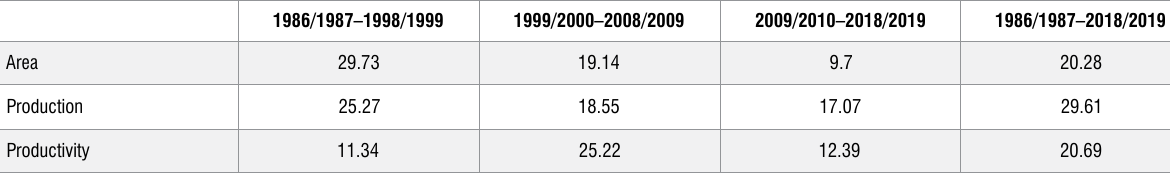
Instability index (Cuddy-Della Valle Index) of rice production in Tanzania